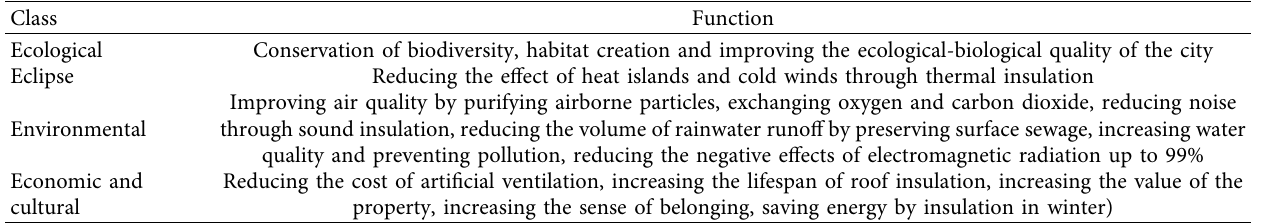
Table 8: Summary of the benefits of green